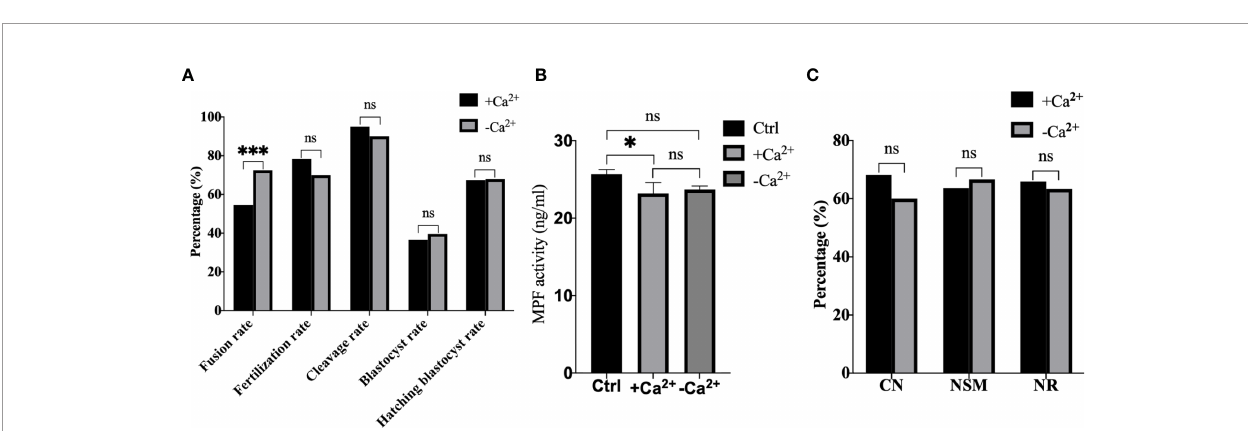
FIGURE 7 | A Ca 2+ free manipulation medium did not inhibit premature activation. (A) A Ca 2+ free medium signi fi cantly improved the fusion rate of mouse reconstructed oocytes. Data is expressed as a percentage (%). ns P>0.05, ***P<0.001. (B) The MPF activity decreased signi fi cantly in +Ca 2+ , with no statistical difference between -Ca 2+ and +Ca 2+ /Ctrl. Data is expressed as mean ± standard deviation. ns P>0.05, *P<0.05. Value, the MPF activity per 100 oocytes (ng/ml). (C) There was no statistical difference in CN, NSM, and NR between +Ca 2+ and -Ca 2+ . ns P>0.05. Data is expressed as a percentage (%). +Ca 2+ represents the Ca 2+ medium group, and -Ca 2+ represents the Ca 2+ free medium group.